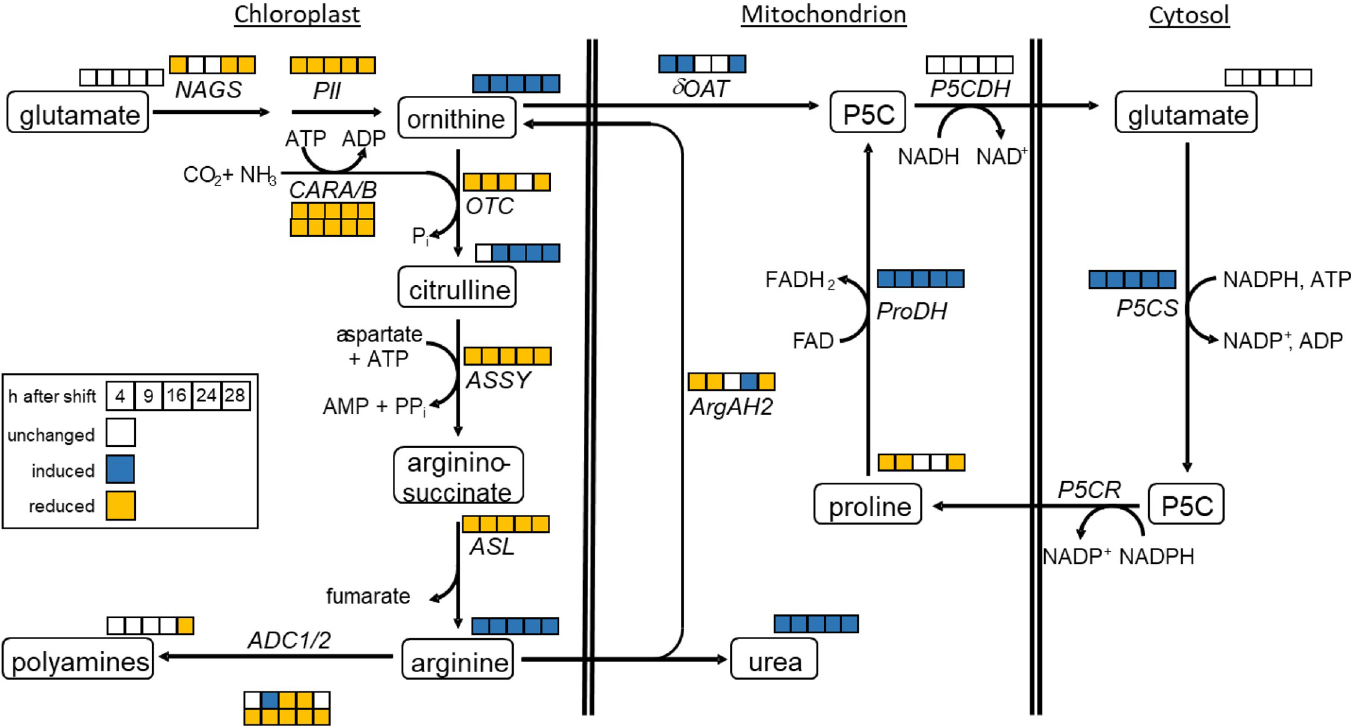
Fig 9. Integration of metabolite and transcript data of ornithine-linked pathways. The squares indicate changes on both transcription and metabolic level in response to a CO 2 -shift from 400 ppm to 100 ppm (Student´s t-test, p < 0.05). ADC1/2, arginine decarboxylase 1 and 2; ArgAH, arginine amidohydrolase; ASL, argininosuccinate lyase; ASSY, argininosuccinate synthetase; CARA, carbamoyl phosphate synthetase A; CARB, carbamoyl phosphate synthetase B; NAGS, N-acetyl-L-glutamate synthase; δ OAT, ornithine- δ -aminotransferase; OTC, ornithine transcarbamylase; PII, PII protein; P5CDH, pyrroline-5-carboxylate dehydrogenase; P5CS, pyrroline-5-carboxylate synthetase; P5CR, pyrroline-5-carboxylate reductase; PRODH, proline dehydrogenase. Blue: significantly induced, orange: significantly reduced, white: unchanged.